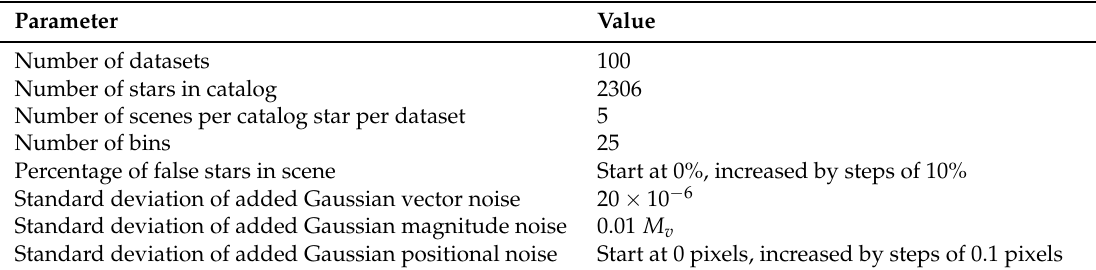
Table 4. Sensitivity to combination of noise factors analysis dataset parameters.